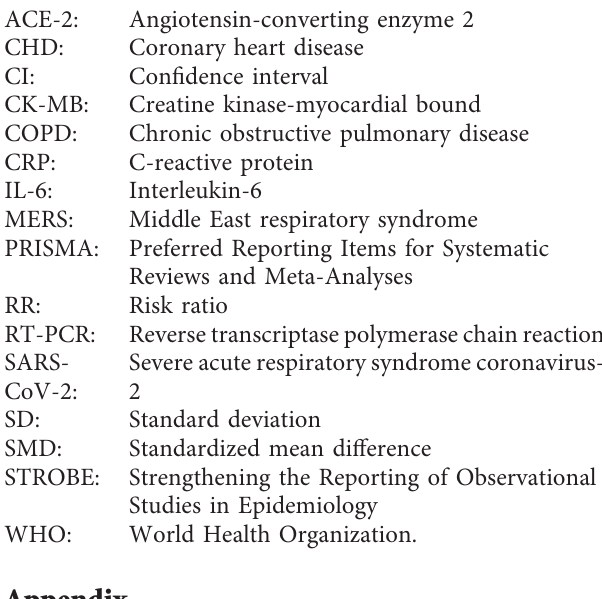
Figure S1: the pooled case fatality rate among COVID-19 patients in the included studies. Figure S2: the pooled prevalence of elevated cTn among hospitalized patients with COVID-19. Figure S3: funnel plots investigating the pub- lication bias for the outcomes of standardized mean dif- ferences in cTn (a) and NT-proBNP (b) and the risk of death among patients with normal or abnormal cTn (c). ( Sup- plementary Materials